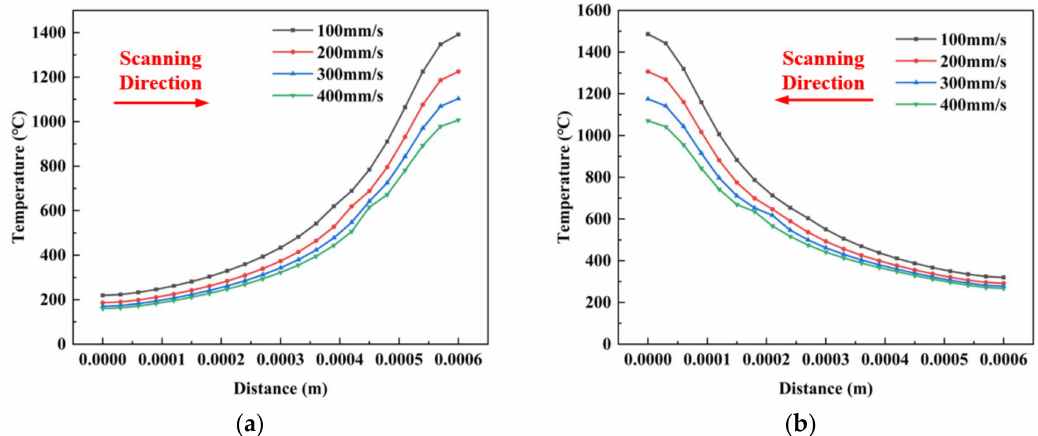
Figure 9. Different scanning speed temperature distributions at the end of two scans. ( a ) temperature distribution at the end of the first scans ( b ) temperature distribution at the end of the second